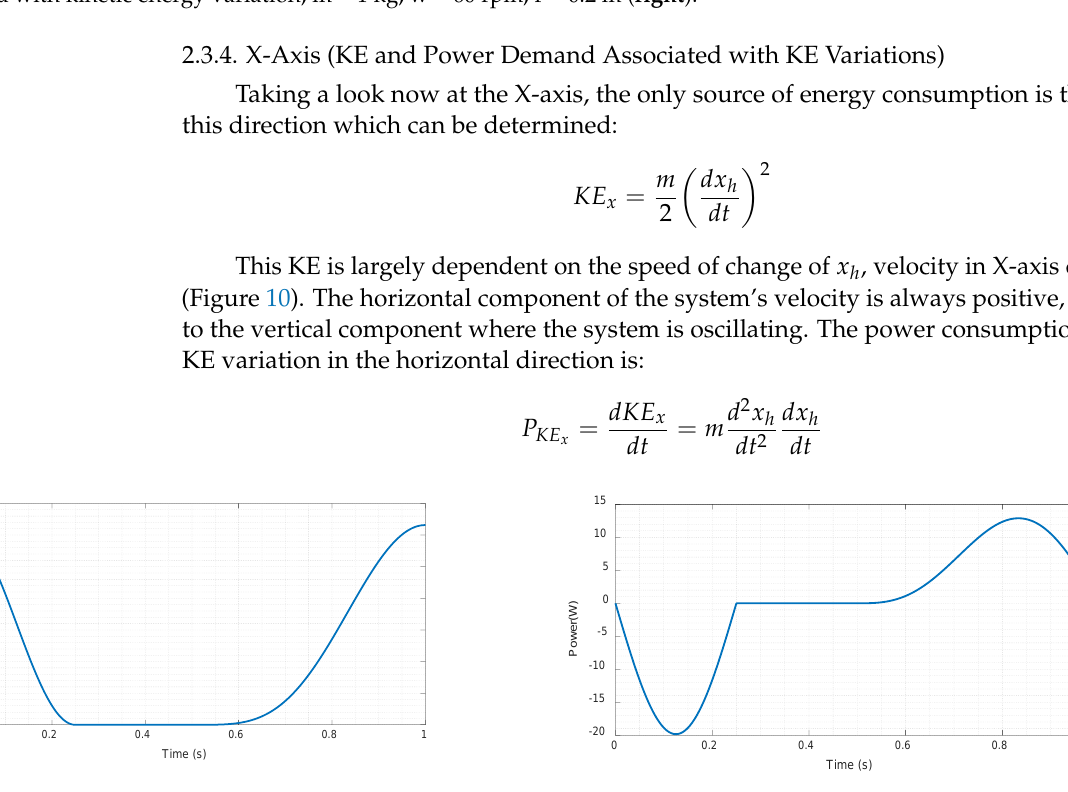
Figure 10. Kinetic energy in the X-axis of the system with w = 60 rpm, m = 1 kg and r = 0.2 m ( left ), and power consumption associated with kinetic energy variation, m = 1 kg, w = 60 rpm, r = 0.2 m ( right ).